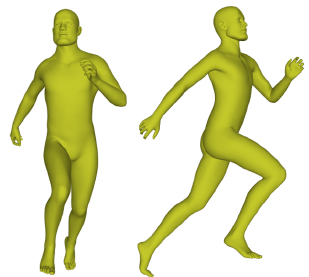
Figure 1. Rotating the left pose obtains a different one shown on the right.